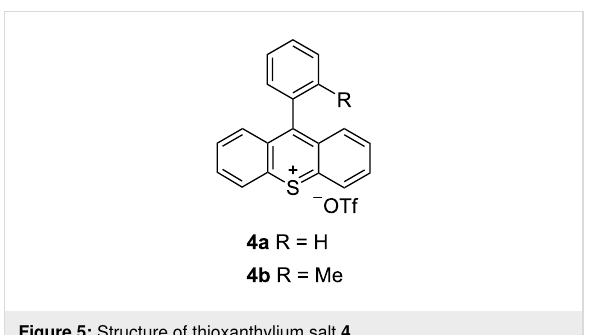
Figure 5: Structure of thioxanthylium salt 4 .